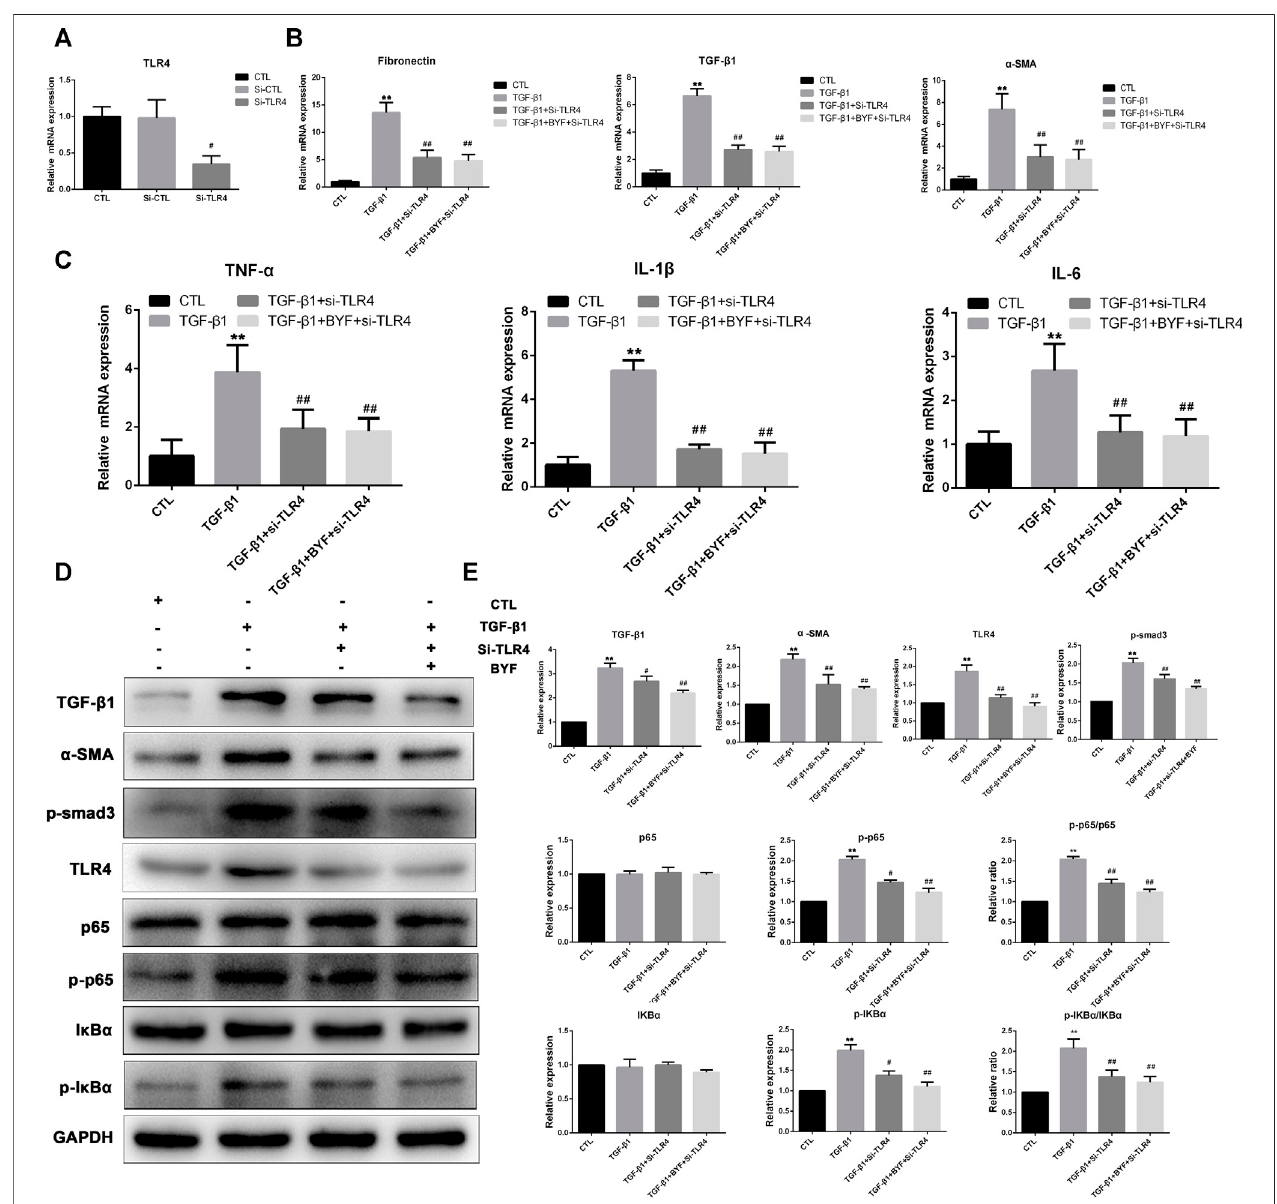
FIGURE 7 | Silencing TLR4 signi fi cantly suppresses BYF inhibitory effect on TGF- β 1-induced fi brogenesis and in fl ammation and NF- κ B pathway activation in HK2 cells. (A) TLR4 qPCR validation in HK-2 cells transfected with TLR4 siRNA. (B) Fibrotic markers qPCR validation between groups. (C) In fl ammatory factors qPCR validation between groups. TLR4/NF- κ B signaling rescue assay WB validation (D) and quantitative analysis (E) in indicated groups. All values are presented as means ± SD. n (cid:1) 3 independent experiments for each indicator. * p < 0.05 and ** p < 0.01 vs. the CTL group; # p < 0.05 and ## p < 0.01 vs. the CKD